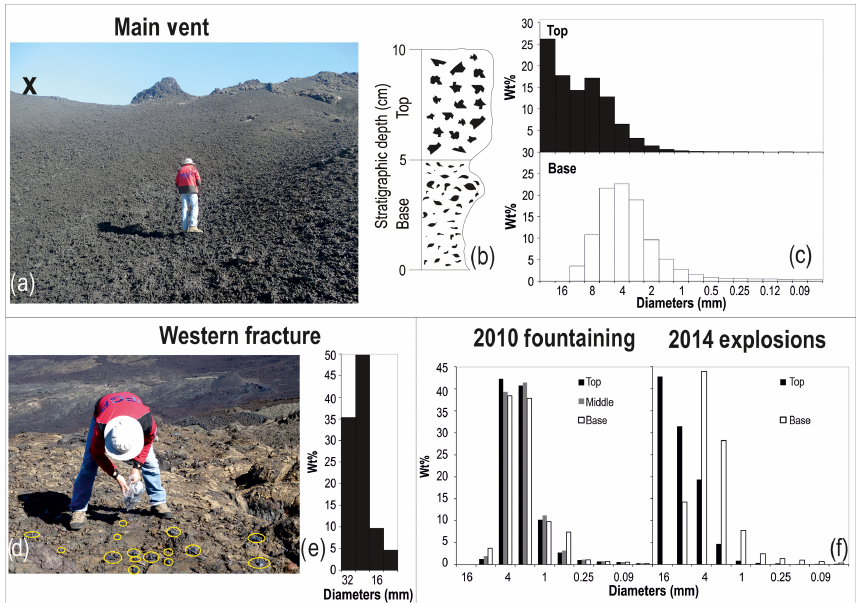
Figure 3. (a) Continuous blanket of scoria fallout deposit emitted from the MV (Fig. 1 for location) during the June 2014 eruption at PdF. The black cross locates the position of the MV (see Fig. 1 for the location). (b) Schematic stratigraphic log of the scoria fallout deposit emplaced during the June 2014 eruption at the MV. (c) Grain size histograms of the base and the top of the deposit of the MV; the particle diameters are at half phi. (d) Scattered scoria (outlined in yellow) from the WF (see Fig. 1 for the location). (e) Grain size histogram of the scoria deposit at the WF; the particle diameters are at half phi. (f) Comparison between the grain size histograms for the 2010 Hawaiian fountaining and the 2014 MV activity; both the particle axes are reported in full phi for